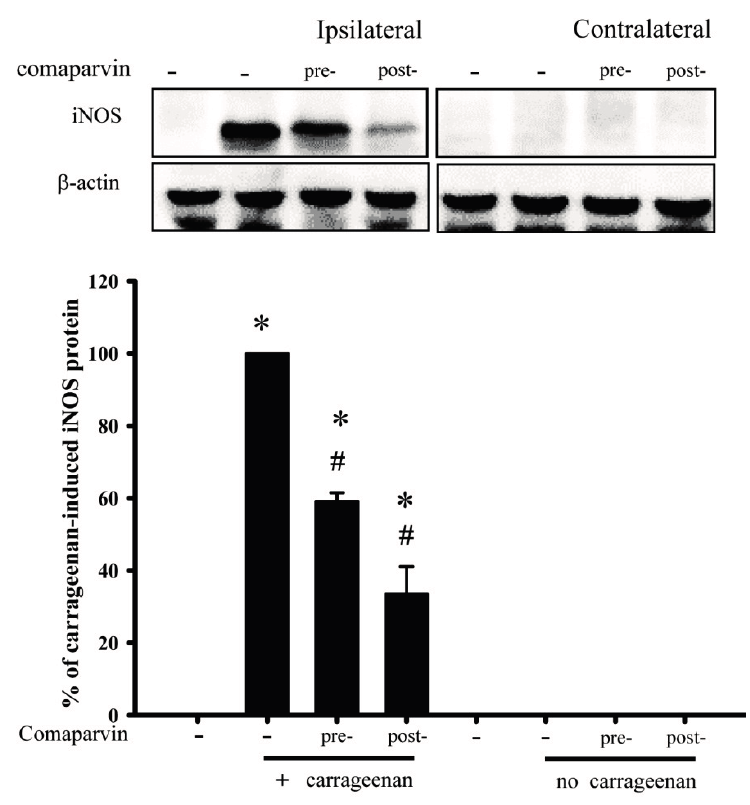
2.8. Effects of Comaparvin on Carrageenan-Induced iNOS Expression in Inflamed Paw Tissue Western blot analyses were used to detect iNOS expression in hind paw tissue. Rats were sacrificed 24 h after carrageenan injection and tissue was collected from the ipsilateral paw (right paw) and contralateral paw (left paw) (Figure 9). There was no significant iNOS protein expression in the ipsilateral paw tissue of the control group. After carrageenan injection, iNOS protein expression was considered 100% in the carrageenan group, and the relative iNOS protein expression in the pre-treatment and post-treatment groups was 59.1% ± 2.3% and 33.52% ± 7.6%, respectively. There was no significant iNOS protein expression in tissue in the contralateral paw. Pre-treatment and post-treatment with comaparvin both inhibited carrageenan-induced iNOS protein expression in paws. Figure 9. Inhibitory effect of comaparvin on the expression of carrageenan-induced iNOS protein expression in rat paw tissue. Western blot analyses of expression of iNOS and β -actin protein in paw tissues after carrageenan injection. Intraplantar carrageenan injection induced significant iNOS protein expression in ipsilateral (carrageenan injection site) but not contralateral paw tissues at 24 h. Administration of a subcutaneous injection of comaparvin (30 mg/kg) significantly inhibited carrageenan-induced upregulation of iNOS protein expression. β -actin protein expression remained unchanged in all groups. Quantification data show the mean ± SEM values for four different experiments. Pre, comaparvin pre-treatment at 1 h before carrageenan injection. Post, comaparvin post-treatment at 4 h after carrageenan injection. Data are the mean ± SEM values. * p < 0.05 compared with the vehicle